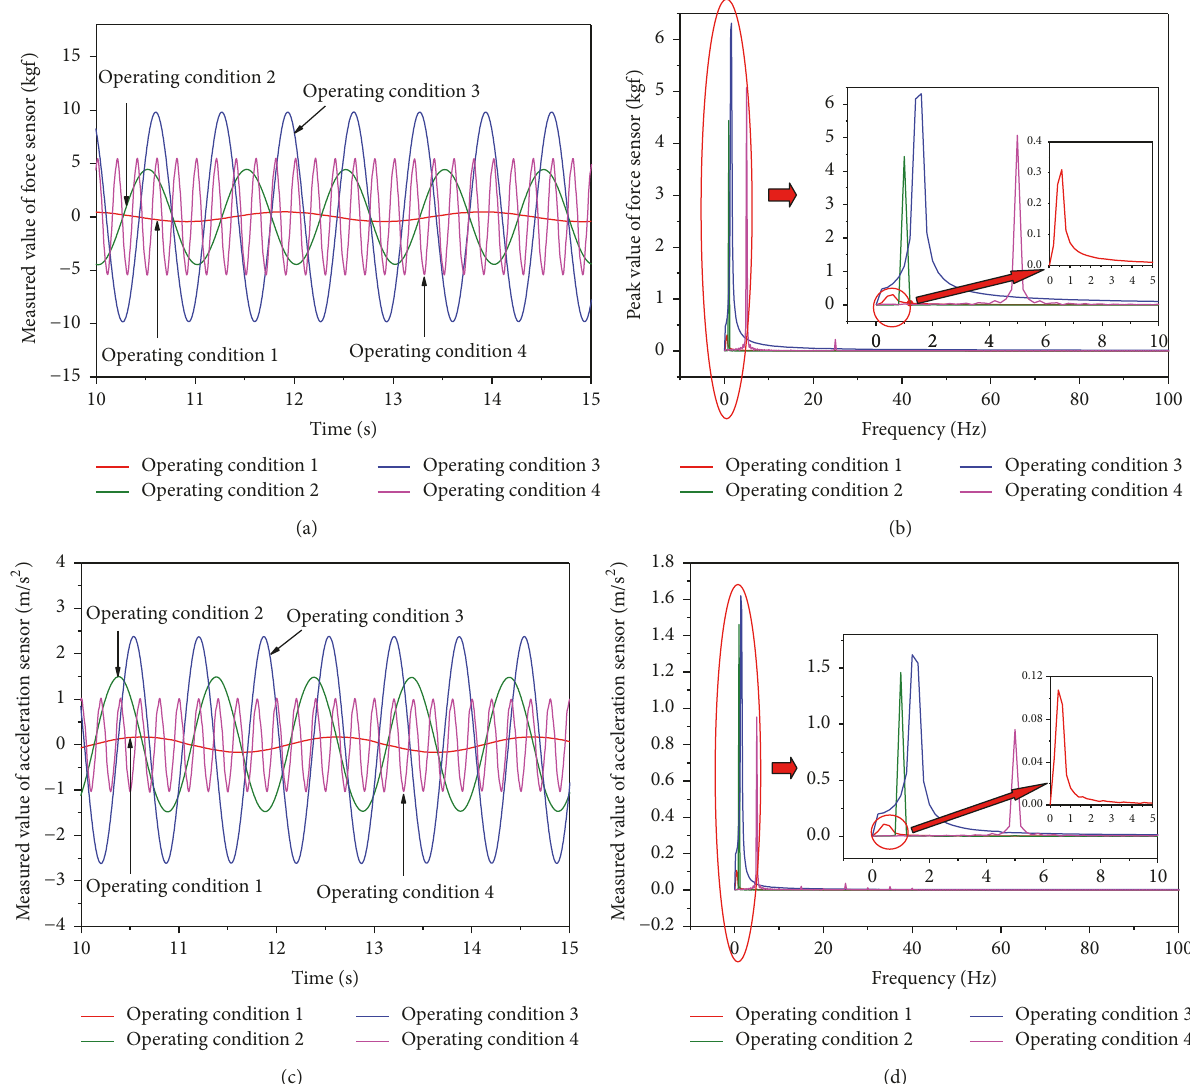
Figure 5: Performance test results for (a) force curve, (b) frequency spectrum of force, (c) acceleration curve, and (d) frequency spectrum of acceleration(operatingcondition1:stiffnessofextensionspring,100 N/m;frequencyofharmonicwave,0.5 Hz;operatingcondition2:stiffness of extension spring, 460 N/m; frequency of harmonic wave, 1Hz; operating condition 3: stiffness of extension spring, 850 N/m; frequency of harmonic wave, 1.5Hz; operating condition 4: stiffness of extension spring, 640 N/m; frequency of harmonic wave,